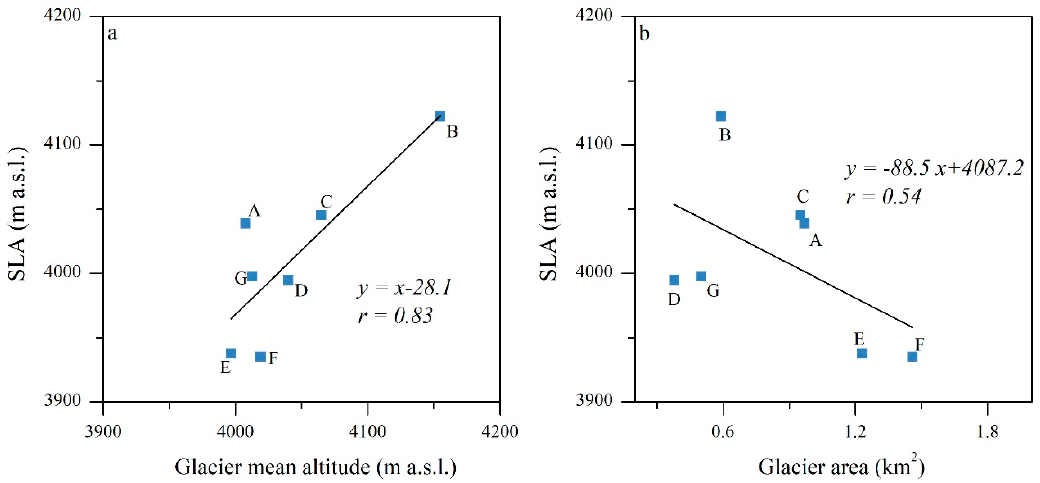
Figure 12. The bivariate relationship between the average snow line altitude (SLA) for each of the glaciers studied over 1994–2016 and (a) the glacier mean altitude and (b) glacier area.